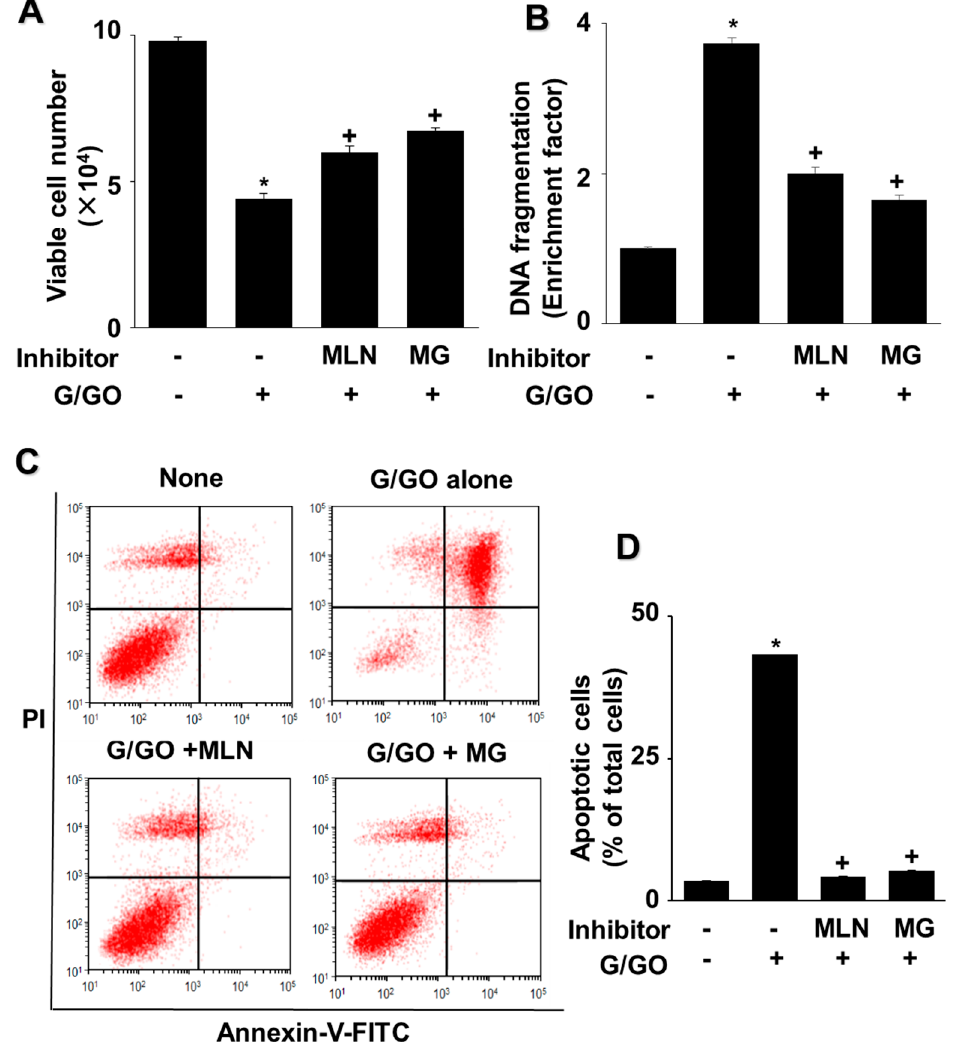
Figure 6. MLN4924 and MG132 inhibited glucose/glucose oxidase (G/GO) − induced cell death, DNA fragmentation, and apoptosis. The cells were incubated with 5 nM MLN4924 or 0.5 µ M MG132 for 1 h, then stimulated with G/GO for 16 h. ( A ) Viable cell counts were determined using the trypan blue exclusion test. ( B ) DNA fragmentation, expressed as an enrichment factor of untreated cells (AST − and G/GO − : cells without astaxanthin treatment, in the absence of G/GO) was set at 1. ( C ) Apoptosis was measured by flow cytometry using annexin V − fluorescein isothiocyanate (FITC)/propidium iodide (PI) staining. ( D ) A bar graph of FITC − labeled annexin V/PI staining is shown. Apoptotic cells were expressed as % of total cells ([apoptotic cell count]/[total observed cell count] × 100). All data are shown as mean ± standard error (SE) of three independent experiments. * p < 0.05 vs. untreated cells (AST − and G/GO − : cells without astaxanthin treatment in the absence of G/GO). + p < 0.05 vs. control cells (Inhibitor − and G/GO+: cells without MLN4924 or MG132 treatment in the presence of G/GO). MLN, MLN4924; MG,